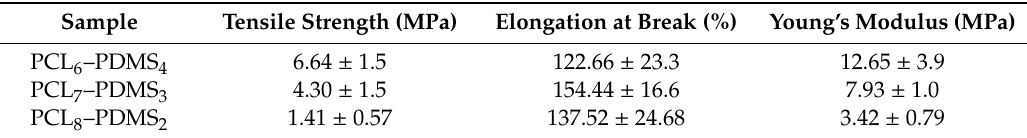
Figure 5. The stress–strain curves of the electro-spun PCL–PDMS copolymer nanofibres obtained from the tensile test. Table 3. The mechanical properties of electro-spun PCL–PDMS copolymer nanofibres.